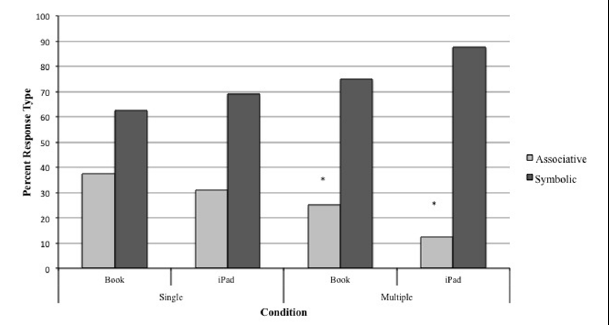
FIGURE 2 | Percentage of symbolic/associative responses in the MappingTest across all conditions. * p <